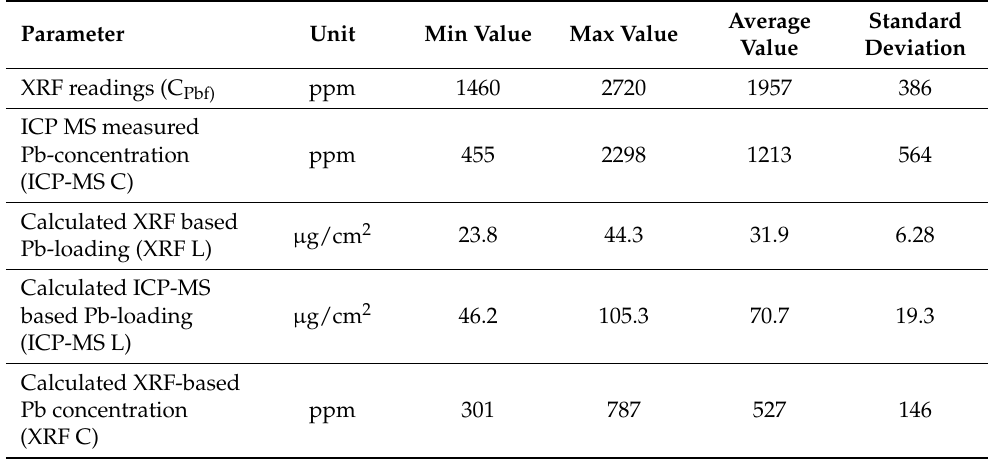
Table 2. Data for the lead content in the building walls’